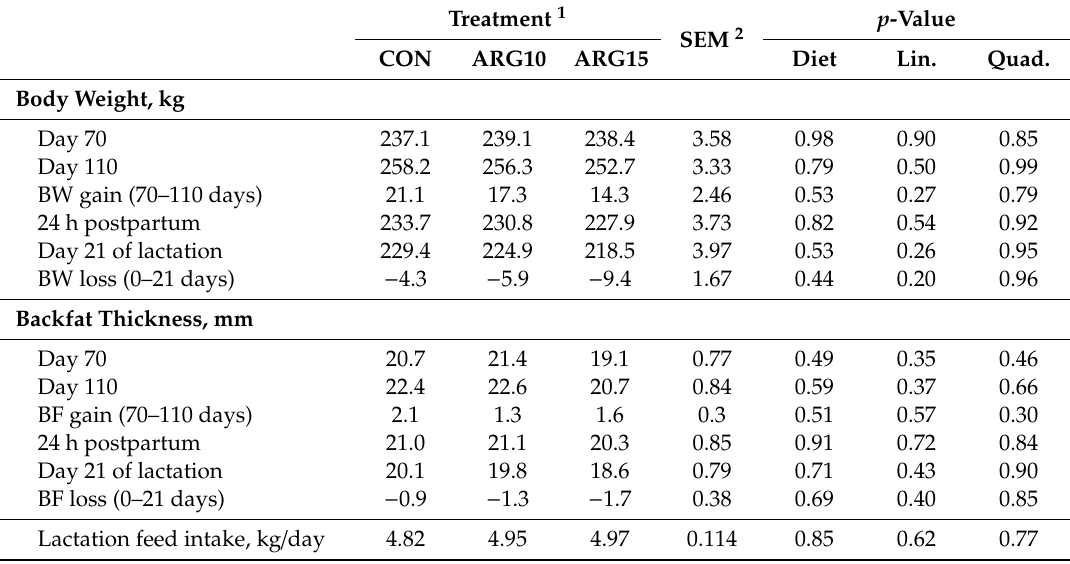
Table 2. E ff ects of arginine supplementation levels on body weight and back-fat thickness in late-gestating sows.